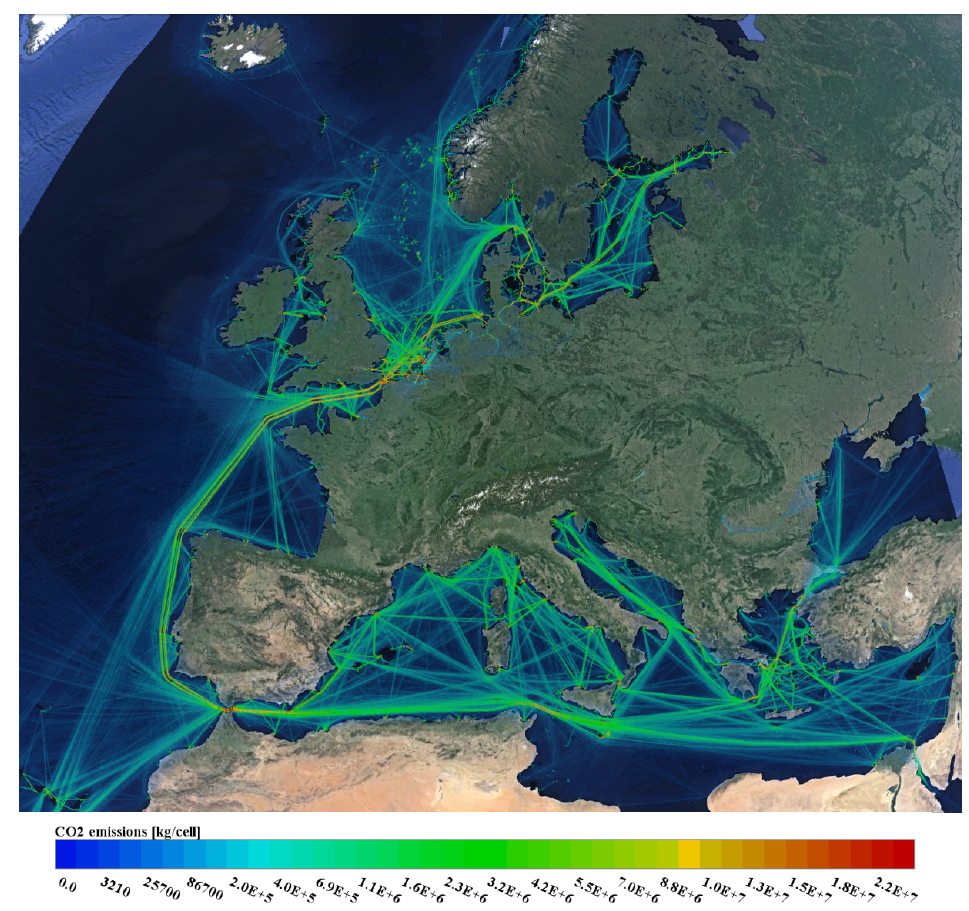
Figure 2. Predicted geographic distribution of shipping emissions of CO 2 in Europe in 2011. The colour code indicates emissions in relative mass units per unit